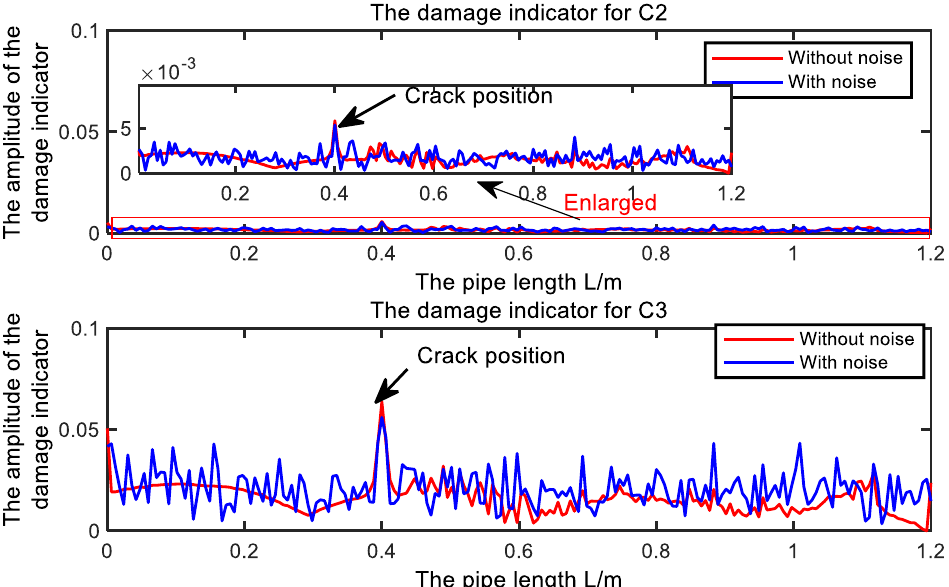
Figure 8. The presented damage indicators for the Scenario 2, i.e., C2 and Scenario 3, i.e., C3 with and without noise.